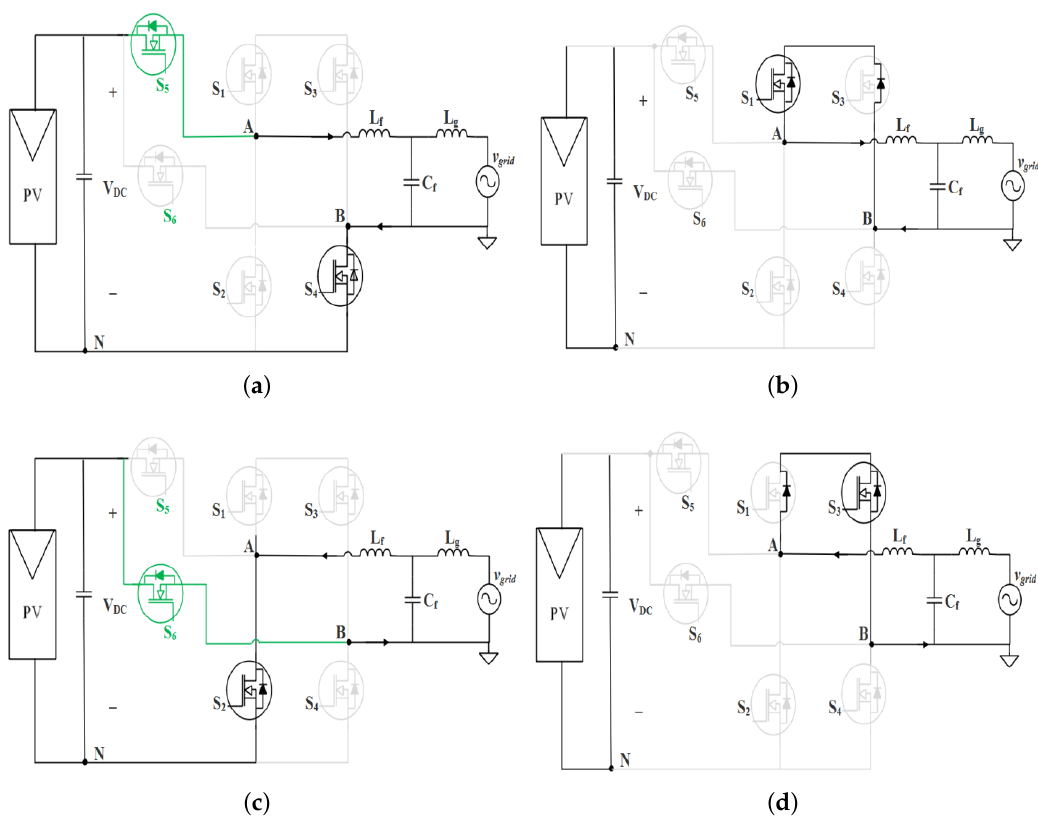
Figure 4. Proposed topology operational modes: ( a ) Active state positive half- cycle; ( b ) Zero-state positive half cycle; ( c ) Active state negative half- cycle; ( d ) Zero-state negative half